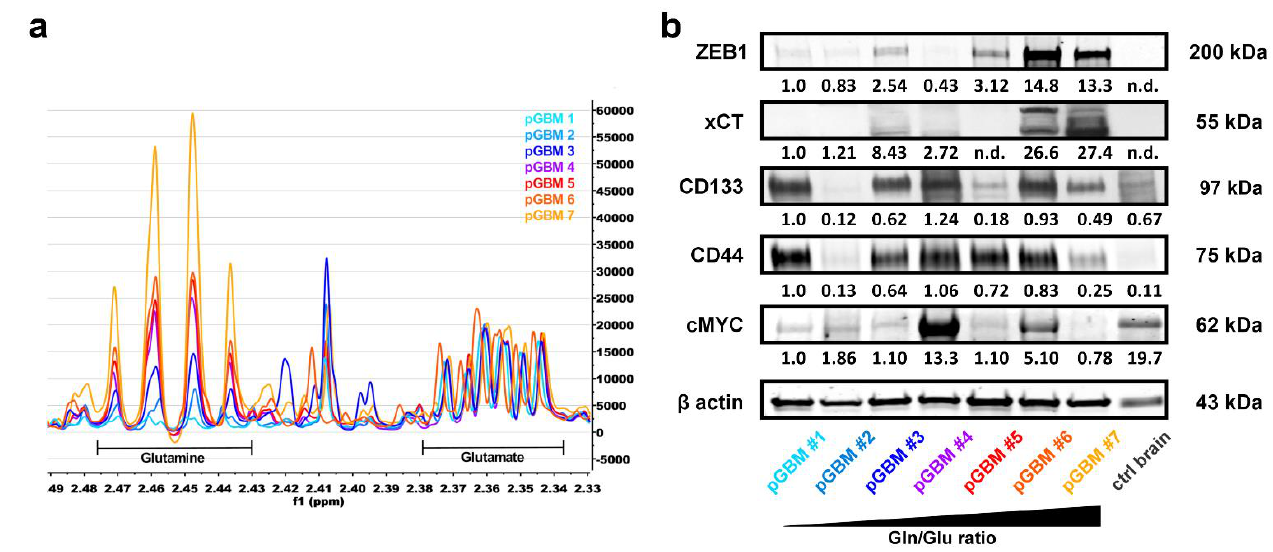
Figure 5. High Gln/Glu ratios predict ZEB1 and xCT expression in primary GBM tumors. ( a ) Expanded regions from 1 H-NMR spectra showing Gln and Glu multiplets of metabolic extracts from seven primary glioblastoma (pGBM) patient samples. Spectra were normalized to the Glu content to visualize the differences in Gln/Glu ratios. ( b ) Immunoblotting of ZEB1, xCT, CD133, CD44, and cMYC protein in GBM patient samples arranged according to their Gln/Glu ratios in ascending order (loading control = β actin). A non-neoplastic brain sample of a trauma patient was blotted as a control. Abbreviations: ctrl, control; Gln, glutamine; Glu, glutamate; n.d., not detectable; pGBM, primary glioblastoma; ppm, parts per million. Supplementary Figures 5 (S5) and 6 (S6) correspond to Figure